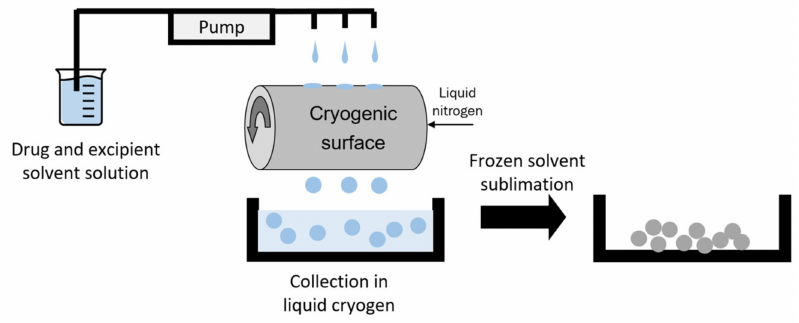
Figure 1. Illustration of TFF process. Modified with permission from MDPI